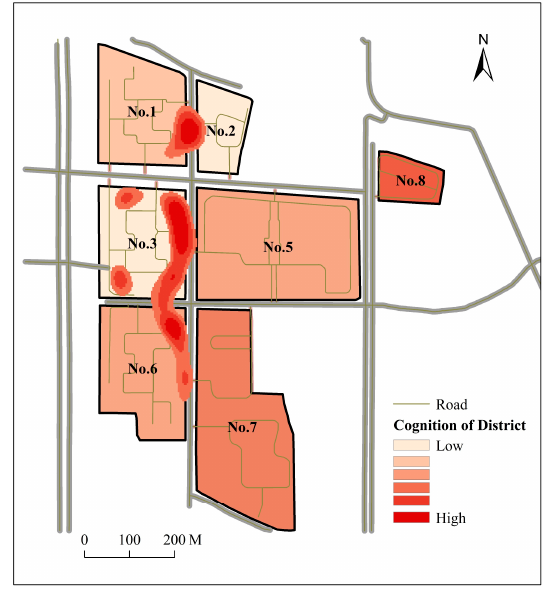
Figure 8. The cognitive results of the district elements.